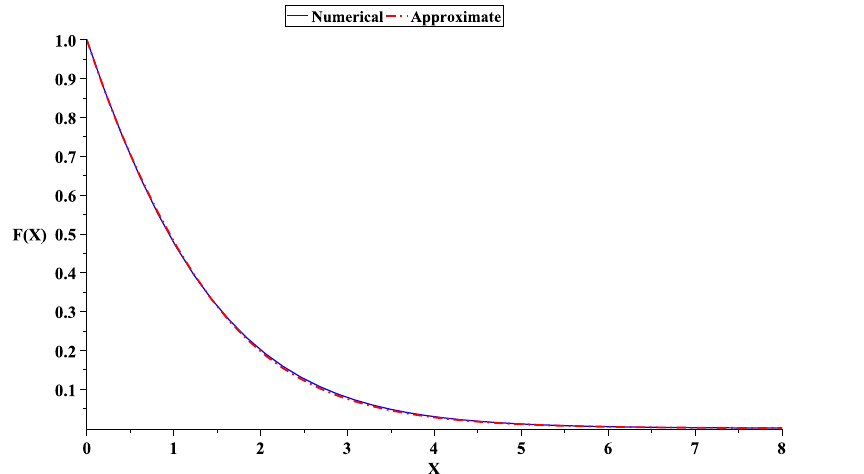
Figure 1. Equation (55) for ε = 0.5 (solid blue line) vs. approximate solution (75) (dash-dot red line).